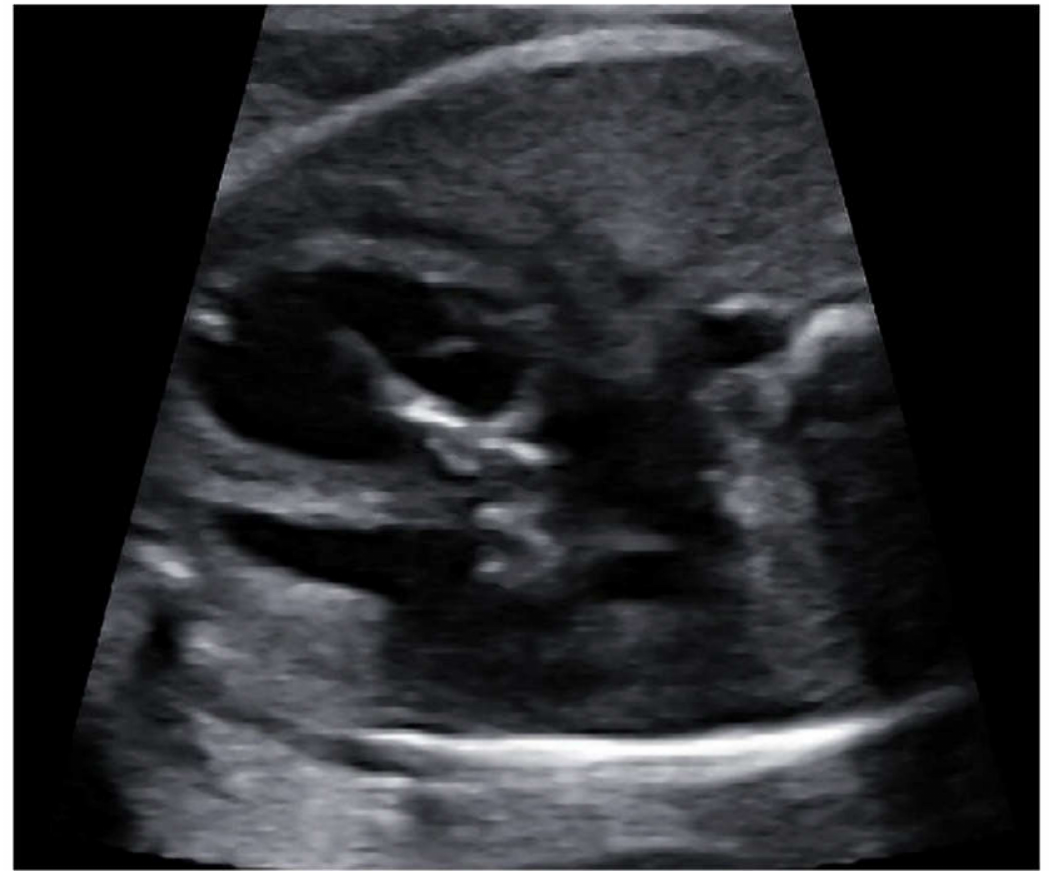
Figure 4. fBAV—the coronary balloon inflated in the aortic valve. The left ventricular apex was punctured and the needle with the coronary balloon was introduced through the aortic